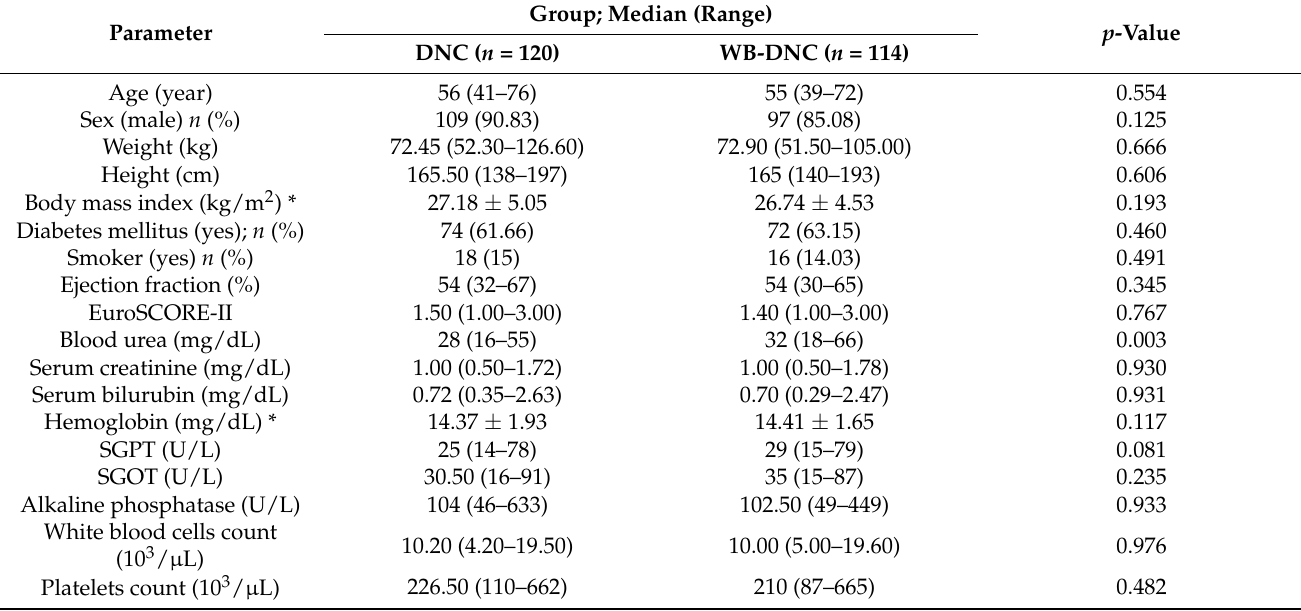
Table 2. Baseline characteristics of patients receiving Del Nido-based